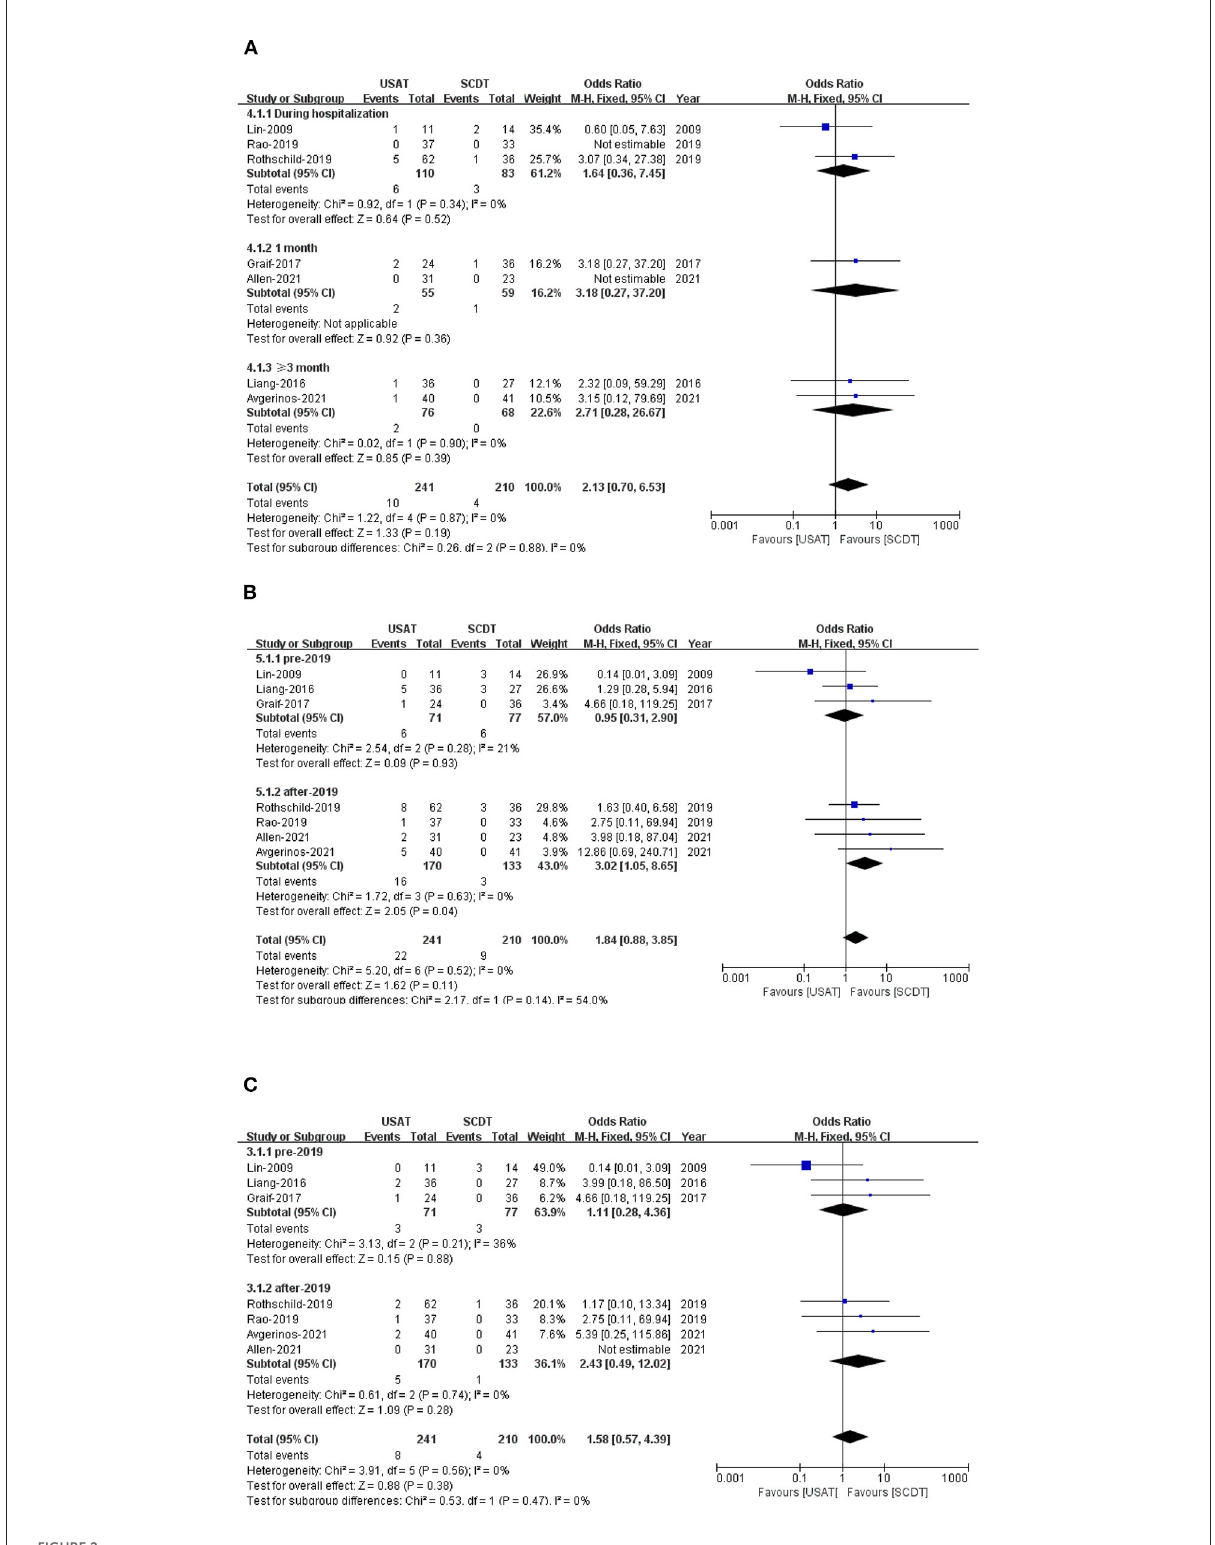
FIGURE2 (A) Forest of all-cause death. (B) Forest of total bleeding. (C) Forest of major